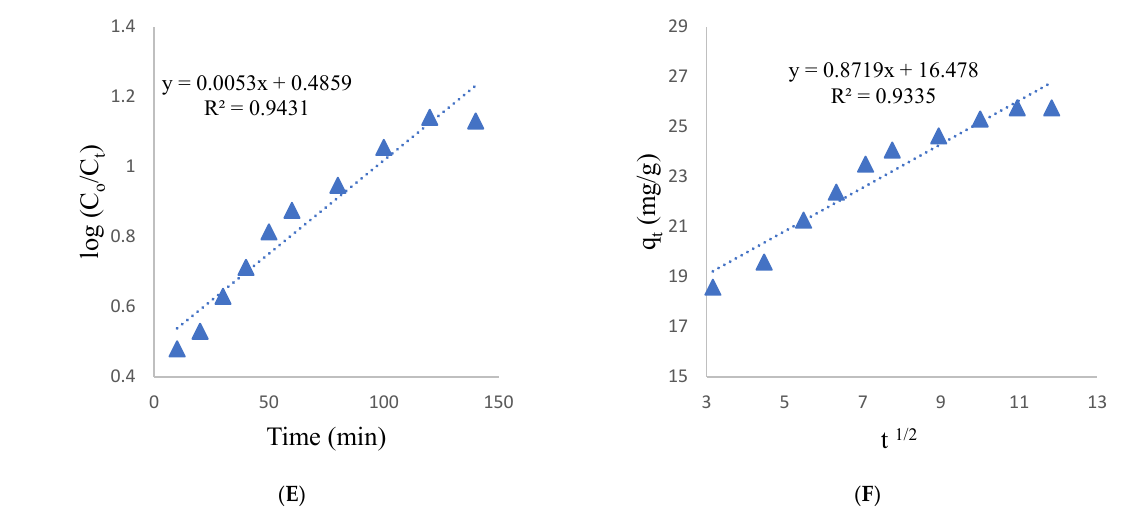
Figure 3. Kinetics of the iron biosorption on prepared biosorbent: ( A ) Effect of contact time ( B ) Pseudo-first-order kinetic model ( C ) Pseudo-second-order kinetic model ( D ) Power function kinetic model ( E ) Intra particular diffusion model ( F ) Natarajan and Khalaf kinetic model.